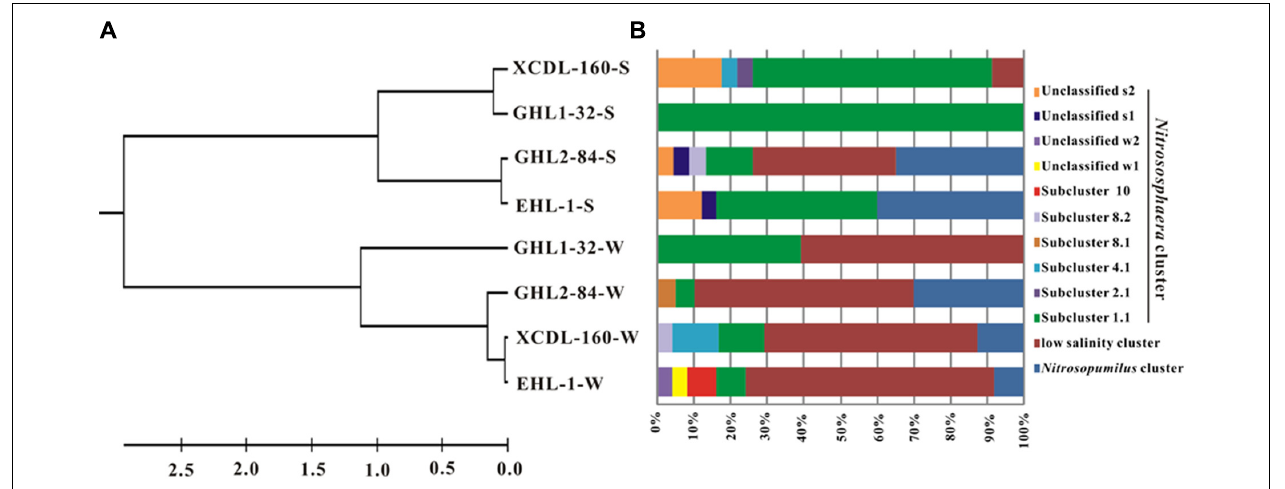
FIGURE 4 | (A) Clustering of the different amoA gene clone libraries based on (cid:2) Cxy values determined from the LIBSHUFF analysis. The tree was constructed with the unweighted-pair group method using average linkages in MEGA 5. The parameter (cid:2) Cxy in the LIBSHUFF analysis represents the difference in coverage of any two clone libraries (the larger (cid:2) Cxy, the